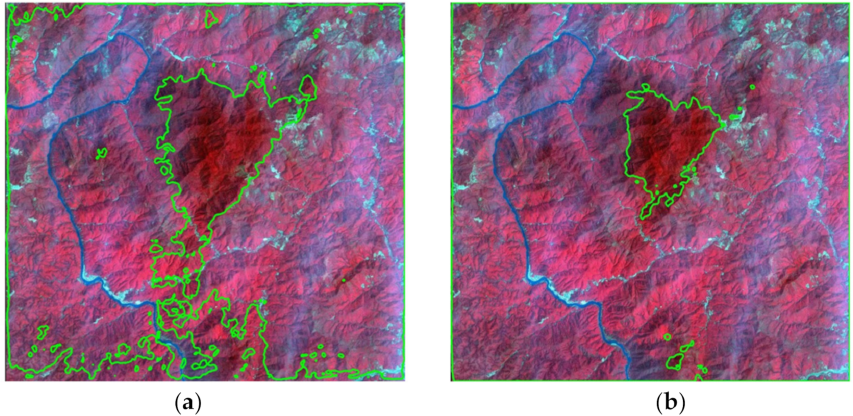
Figure 7. Comparison of mask classification method and per-pixel classification method on AIR-CD dataset. ( a ) Per-pixel classification. ( b ) Mask